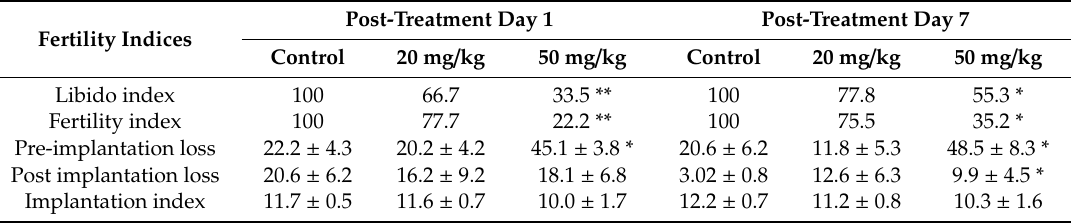
Table 3. Fertility indices of female rats mated with male rats treated either with 20 or 50 mg / kg Judo 40 or distilled water